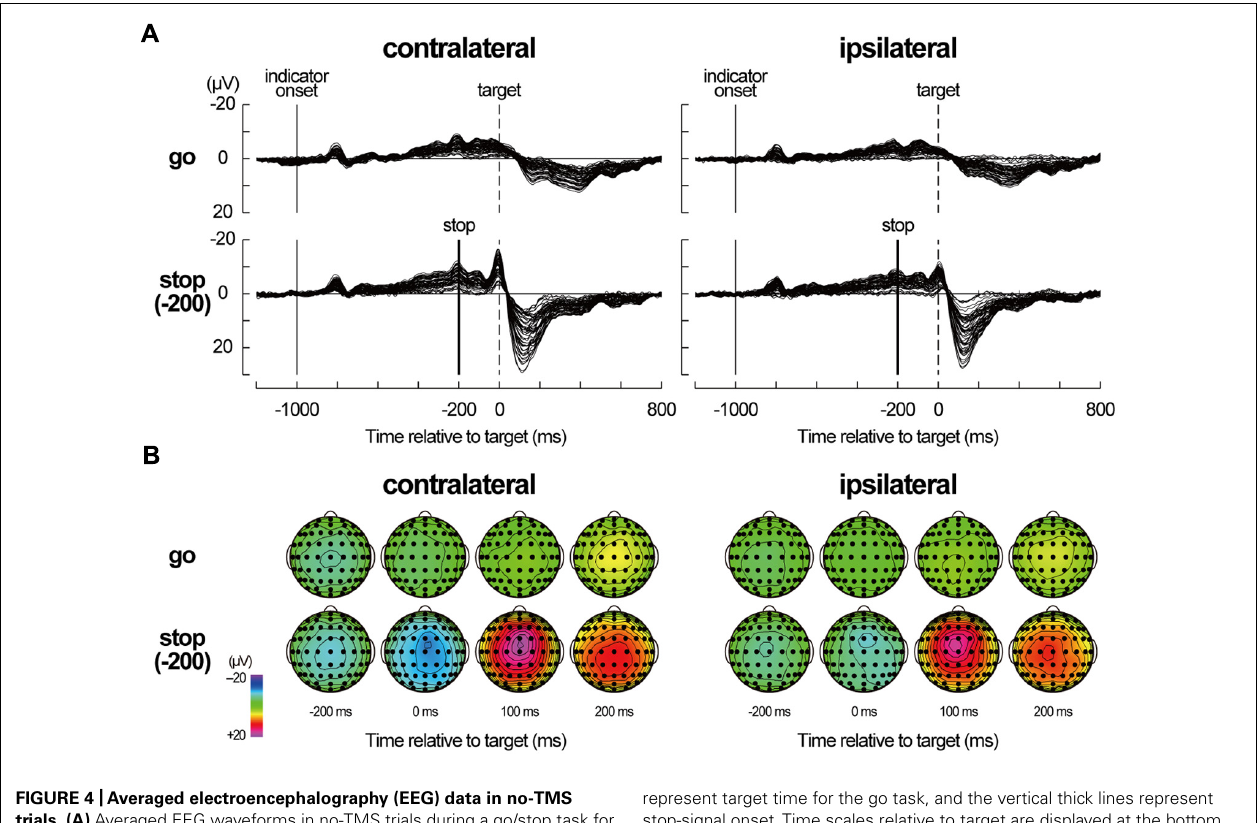
FIGURE 4 |Averaged electroencephalography (EEG) data in no-TMS trials. (A) Averaged EEG waveforms in no-TMS trials during a go/stop task for six participants in a contralateral-TMS session (left two panels) and for six participants in an ipsilateral-TMS session (right two panels). For stop trials, only the waveforms in stop trials with a stop time of − 200 ms [stop( − 200) trials] are displayed.The waveforms of all 61 sites are shown as thin black lines.The vertical thin lines represent indicator onset, the vertical dashed lines